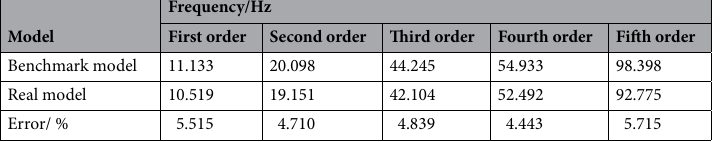
Table 1. Comparison of natural vibration frequencies between the benchmark and representative models. Error = (benchmark frequency -real frequency)/ benchmark frequency ×